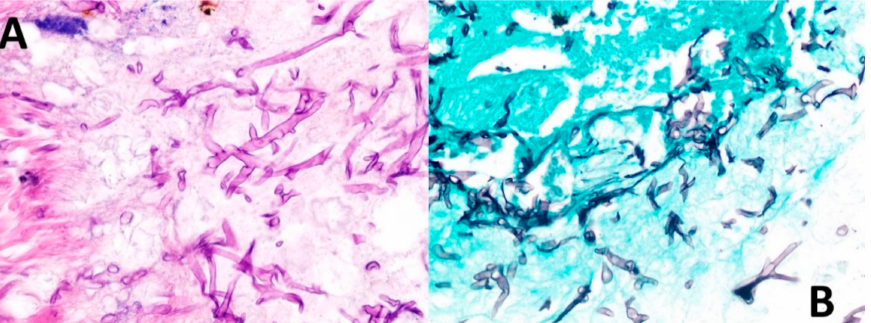
Figure 6. Biopsy findings. ( A ) Routine staining with hematoxylin and eosin shows broad ribbon- shaped hyphae without marked septa, 5–15 microns in diameter and irregular angled branching ranging from 45 to 90 degrees. ( B ) Grocott’s methenamine stain permeates the walls of fungal cells due to its high density of polysaccharides, retaining more aldehyde groups by oxidation of chromic acid and highlighting the hyphal